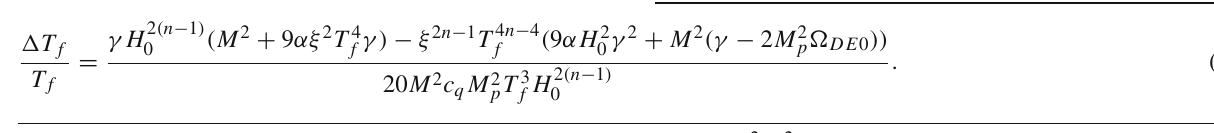
Fig. 4 Hubble parameter versus redshift error bar plot comparing with (cid:2)